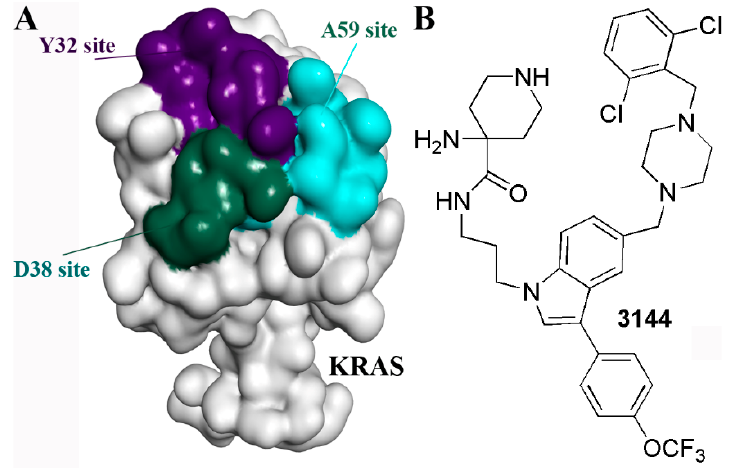
Figure 7. The multivalent strategy for KRAS inhibitors. ( A ) The multiple sites on the KRAS surface. ( B ) The structure of 3144.